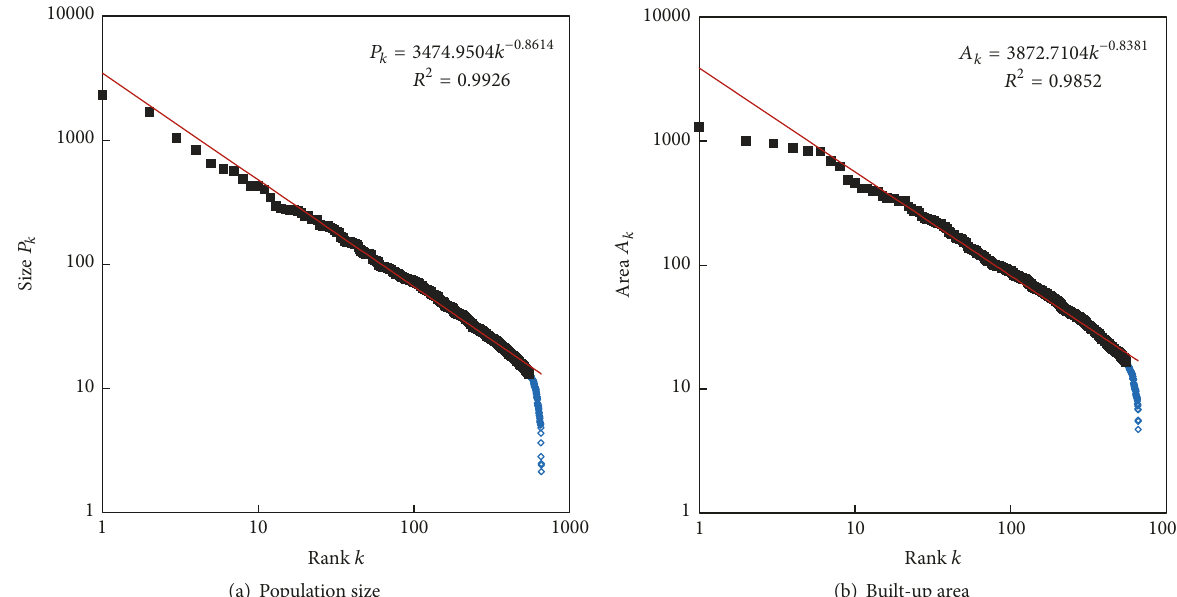
Figure 2: The rank-size distributions of Chinese cities measured by urban population and built-up area in 2010.